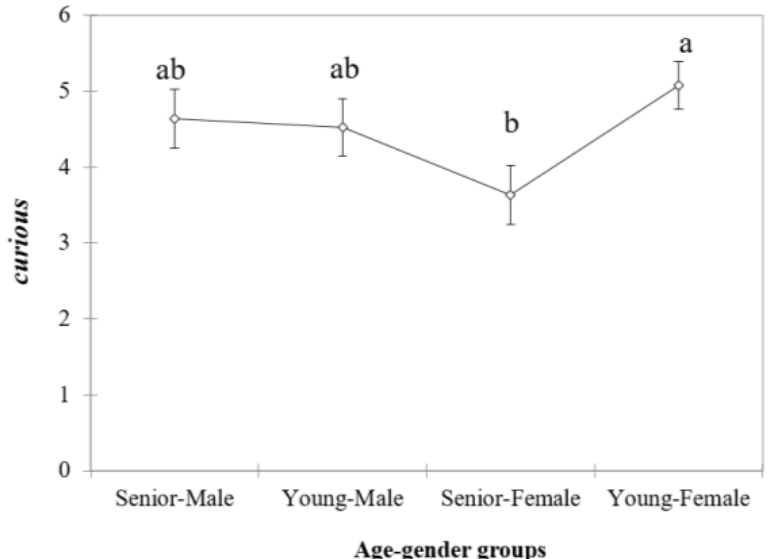
Figure 2. Mean scores (considering the two types of wines) of the emotional term “curious” according to the age–gender group. Different letters (a-b) show significant differences among age-gender groups from Tukey test ( p < 0.05).